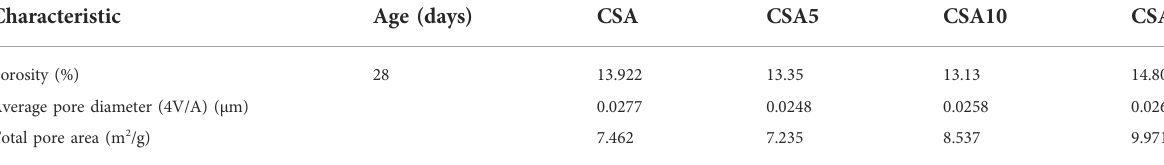
TABLE 4 Mercury porosity, average pore diameter, and total pore area on the mortar tested at 28 days.